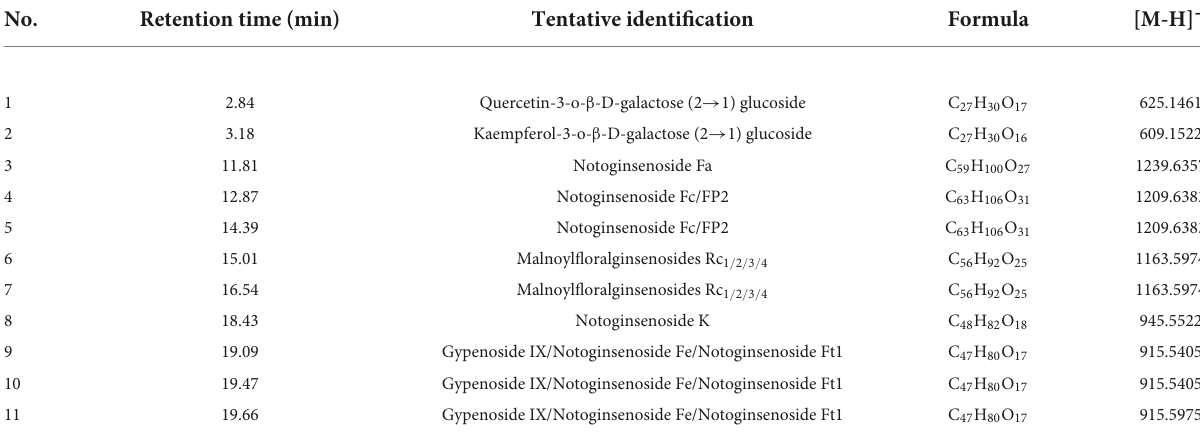
TABLE 4 Principal secondary metabolites in SLPN-instant beverage identified by HPLC-ELSD. No. Retention time (min) Tentative identification